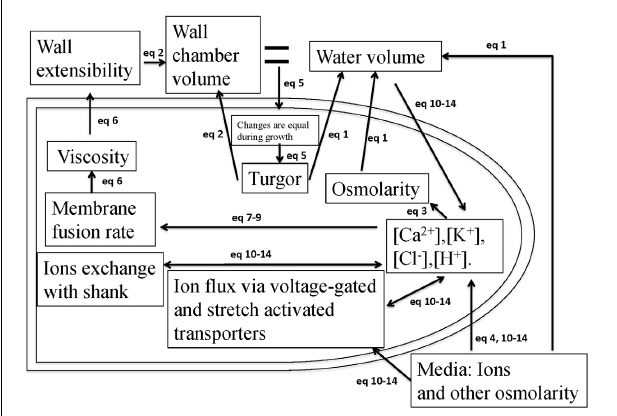
FIGURE 1 | A schematic description of the model that couples hydrodynamics, cell wall and ion dynamics. During pollen tube growth, the relative change in the volume of water and the volume encompassed by the cell wall (cell wall chamber) is equal (Ortega, 2010), and turgor is generated. Calcium affects vesicle secretion rate that affects cell wall viscosity, which further affects cell wall extensibility. Both cell wall extensibility and turgor affect the volume change of the cell wall chamber (Kroeger et al., 2011; Hill et al., 2012). Both turgor and osmotic pressure affect the volume of water (Winship et al., 2010; Hill et al., 2012). Ion concentrations affect cellular osmotic pressure. The equations used to describe these processes are included in the Materials and Methods Section. The parameters and their links with experimental data are included in